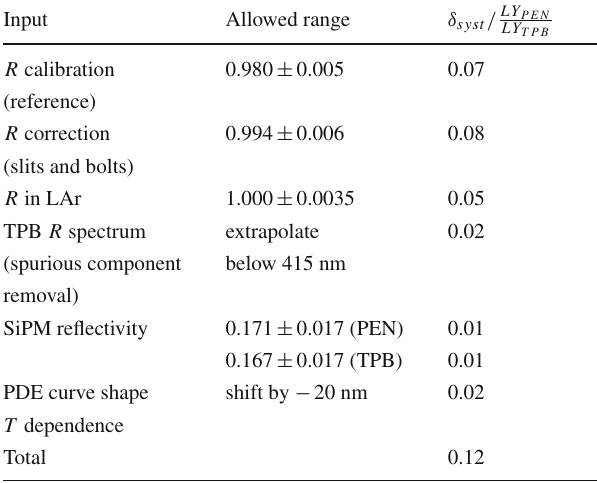
relative to a BaSO 4 reference, with 98.0 ± 0.5% absolute